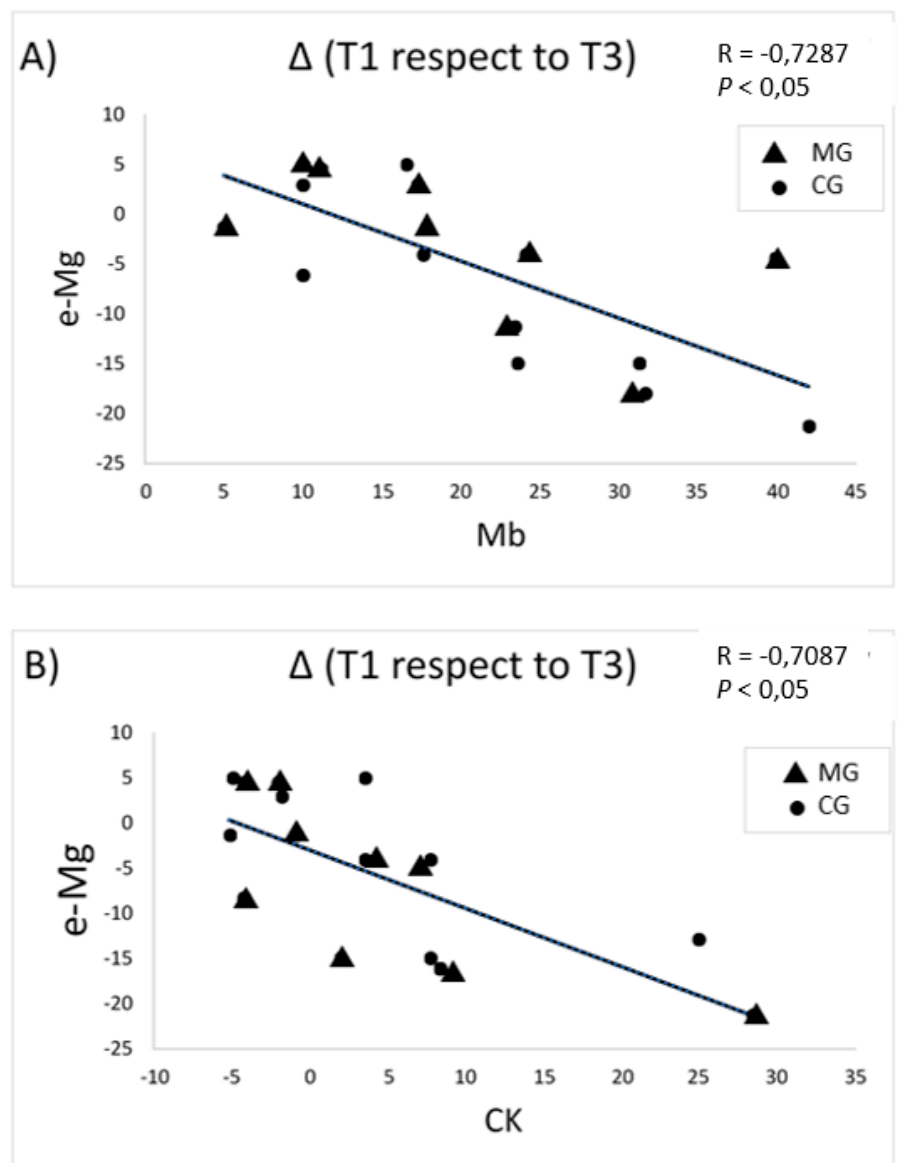
Figure 2. Correlation between changes of erythrocytic-Mg (e-Mg) and myoglobin (Mb) ( A ) and creatine kinase (CK) ( B ) during the stage race. Changes are expressed as differences in certain parameter at the beginning (T1) and the end (T3) of the study ( Δ (T1 respect to T3)), calculated as indicated in the Materials and Methods section.